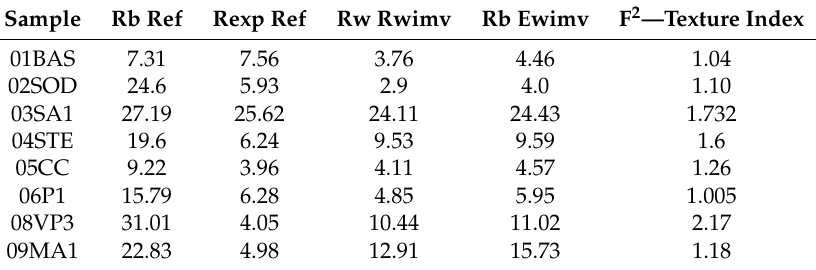
Table 3. Quantitative texture refinement